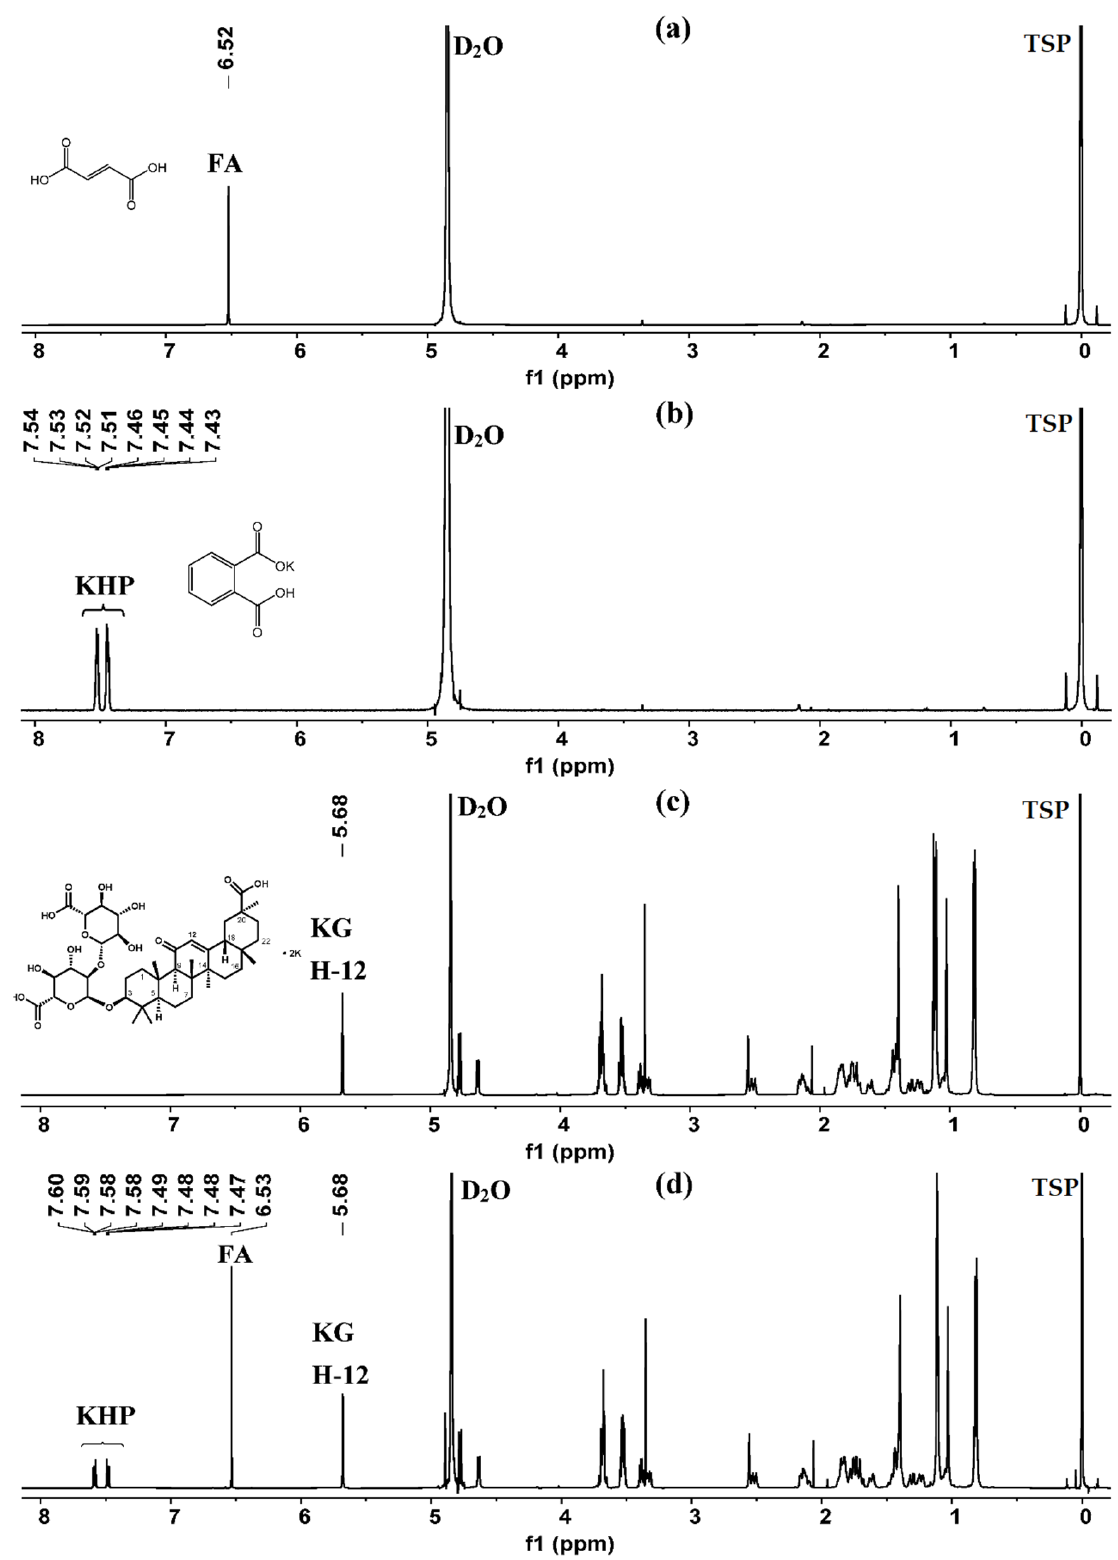
Figure 2. ( a ) 1 H-NMR spectrum of fumaric acid (FA) in D 2 O; ( b ) 1 H-NMR spectrum of potassium hydrogen phthalate (KHP) in D 2 O; ( c ) 1 H-NMR spectrum of dipotassium glycyrrhizinate (KG) in D 2 O; ( d ) 1 H-NMR spectrum of FA, KHP, and KG in D 2 O (500 MHz).